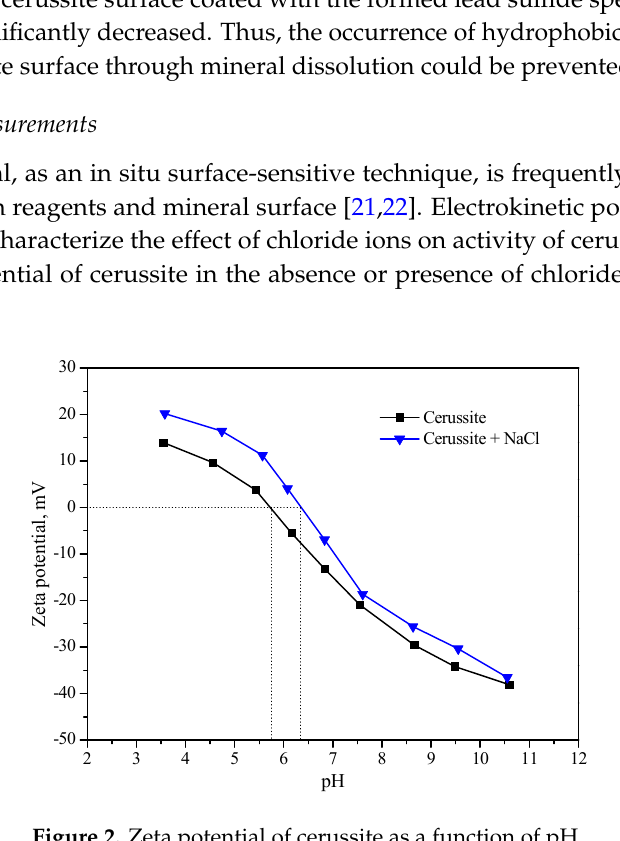
Figure 2. Zeta potential of cerussite as a function of pH.